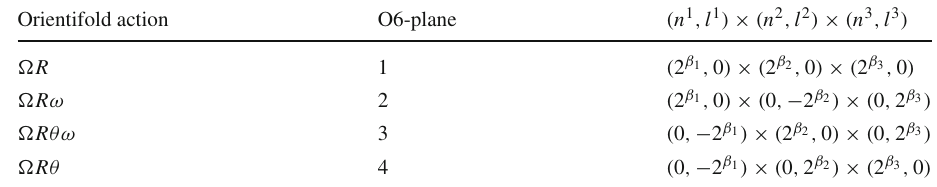
Orientifold action